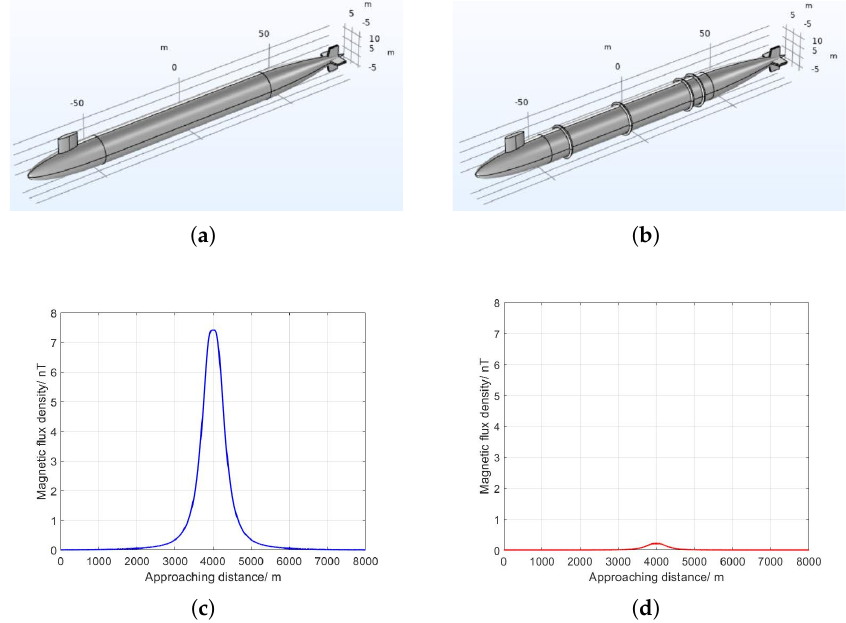
Figure 1. The submarine’s fixed magnetic field before and after degaussing. ( a ) The submarine before degaussing coil installation; ( b ) Submarine after degaussing coil installation; ( c ) Submarine’s fixed magnetic field before degaussing; ( d ) Submarine’s fixed magnetic field after